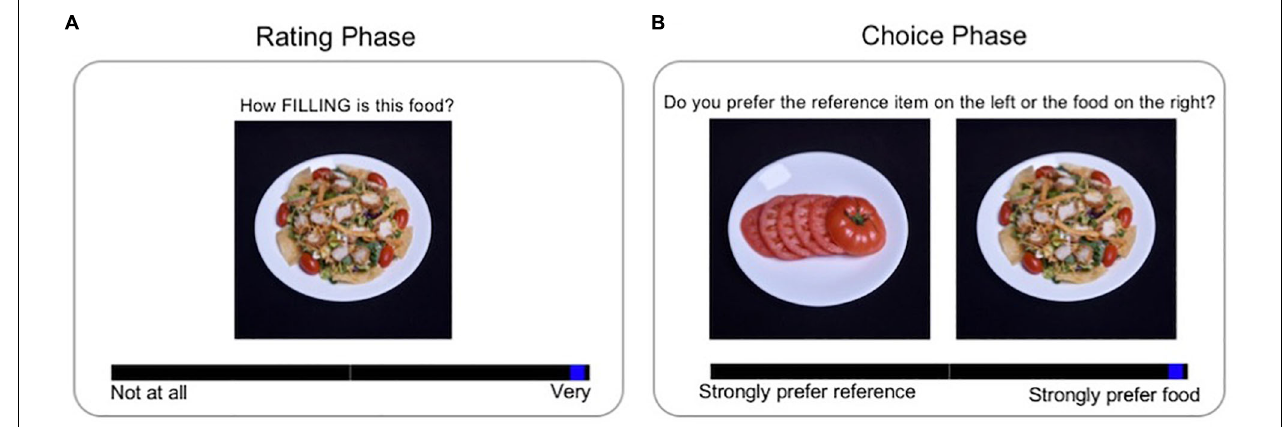
FIGURE 1 | Food rating and choice tasks. The task consisted of two phases: Rating and Food Choice. In the Rating phase (A) , participants viewed each food in their 46-item set consecutively and provided ratings for a particular attribute; this was repeated for each of the 17 attributes. On each trial in the Choice phase (B) , participants indicated their preference for each of the non-reference food items in their set relative to the repeated reference item (previously rated neutral on health and taste).